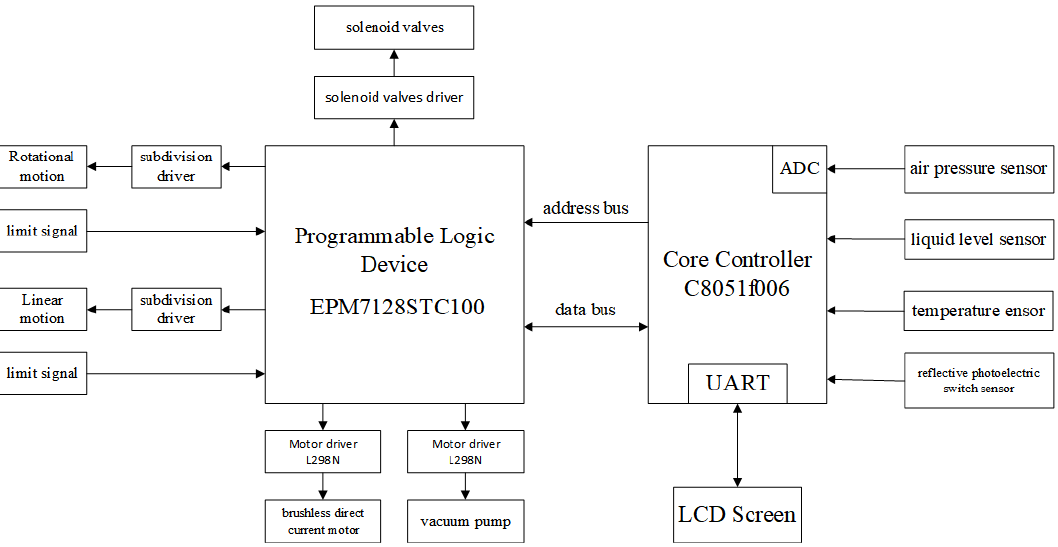
Figure 7. Hardware system schematic diagram.